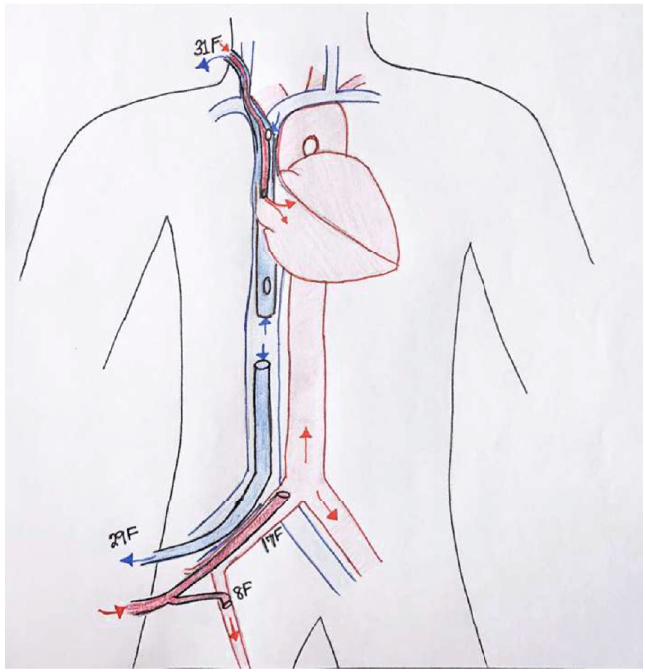
Figure 2: Complete VAV ECMO